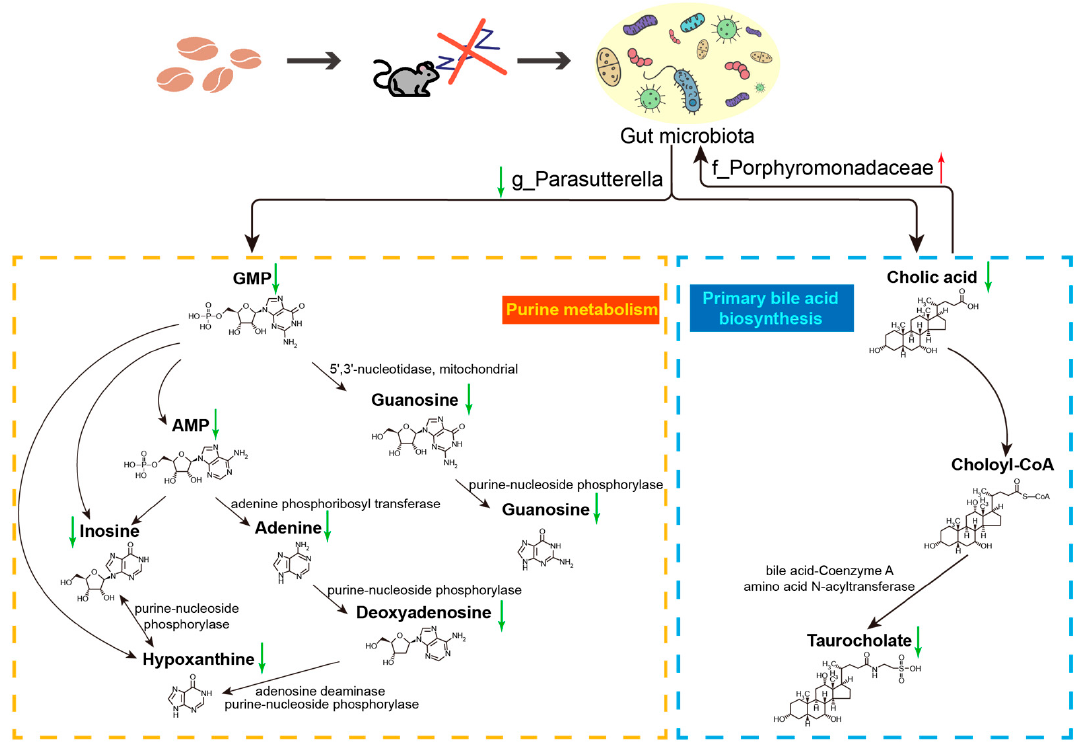
Figure 8. Differential metabolic pathways associated with g_ Parasutterella and f_ Porphyromonadaceae on host metabolism after CISR. The composition of g_ Parasutterella , which was a key factor affecting purine metabolism and primary bile acid biosynthesis, was significantly reduced after CISR. Con- comitantly, the abundance of f_ Porphyromonadaceae was significantly increased, which was affected by bile acid. All enzyme and metabolite names were obtained from the KEGG database.